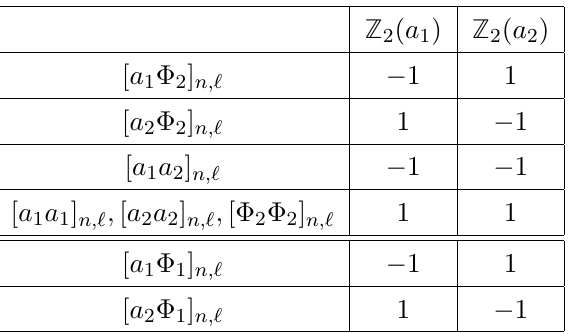
Table 1 . Irreducible representation of the double trace operators under the Z 2 × Z 2 symmetry. The two different blocks correspond to distinct subspaces, where the degeneracies are partly broken by the discrete